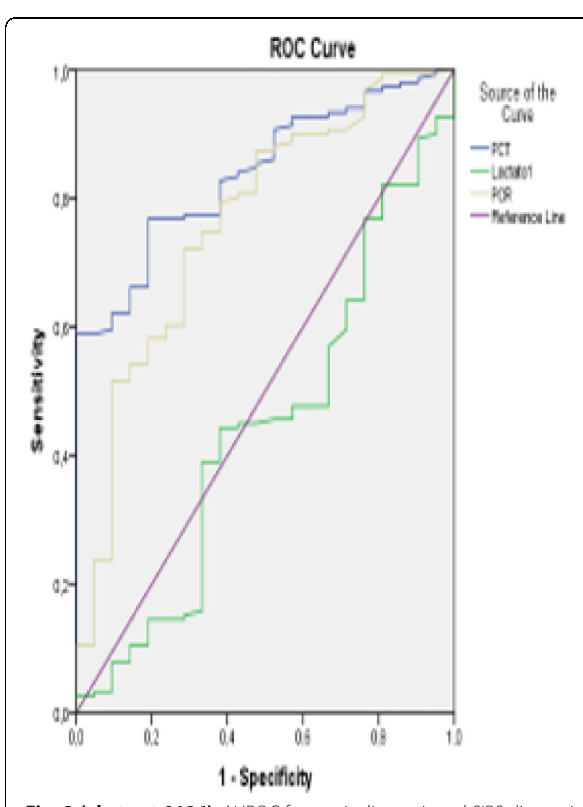
Fig. 3 (abstract 0126) . AUROC for sepsis diagnosis and SIRS diagnosis in critical patients